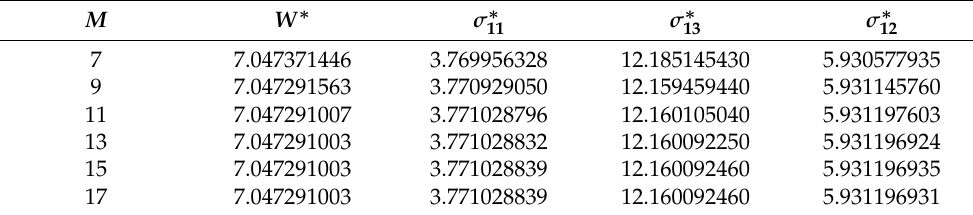
Table 2. Convergence of the results of FG porous nanocomposite piezoelectric square plates. M W ∗ σ ∗